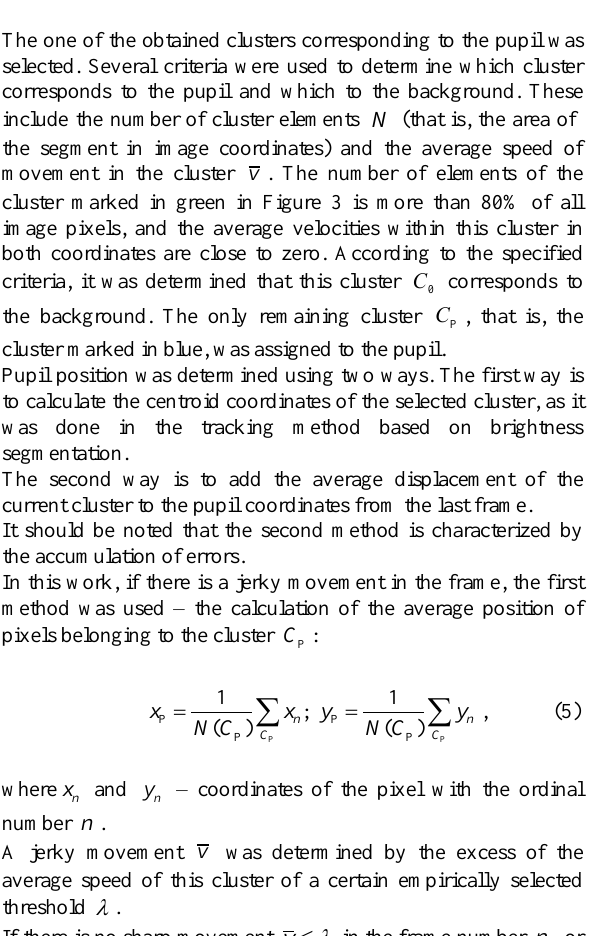
Figure 4 . The result of clustering the displacements obtained by calculating the optical